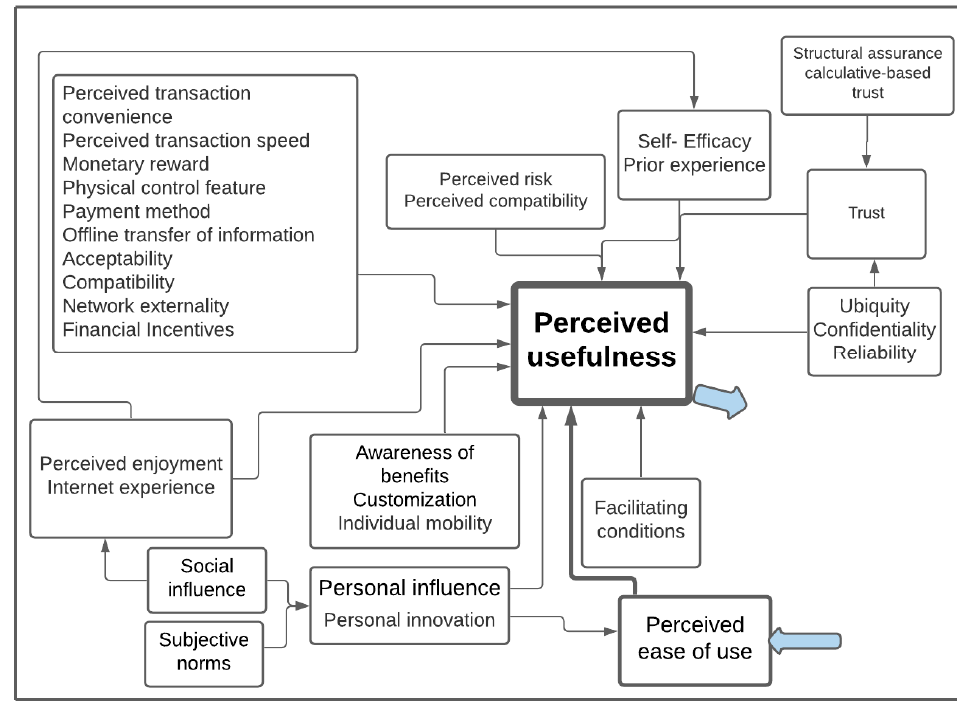
Figure A2. The Perceived usefulness model of electronic payment.